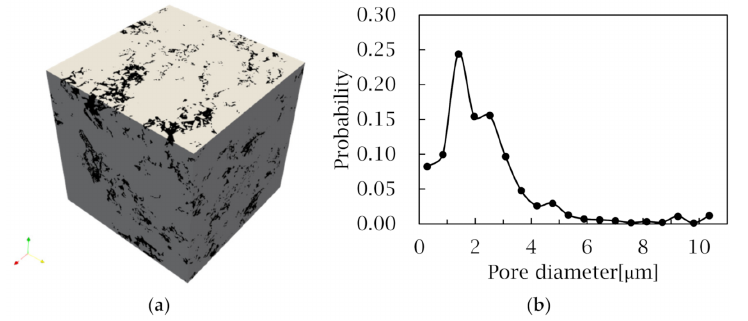
Figure 1. 3D visualization of pore structure of Changqing tight sandstone sample and its pore size distribution. ( a ) Pores and solids are both shown. Pores are shown in black color and solids are shown in gray color. ( b ) Pore size distribution of tight sandstone with characteristic pore diameter d c = 1.4 µ m.